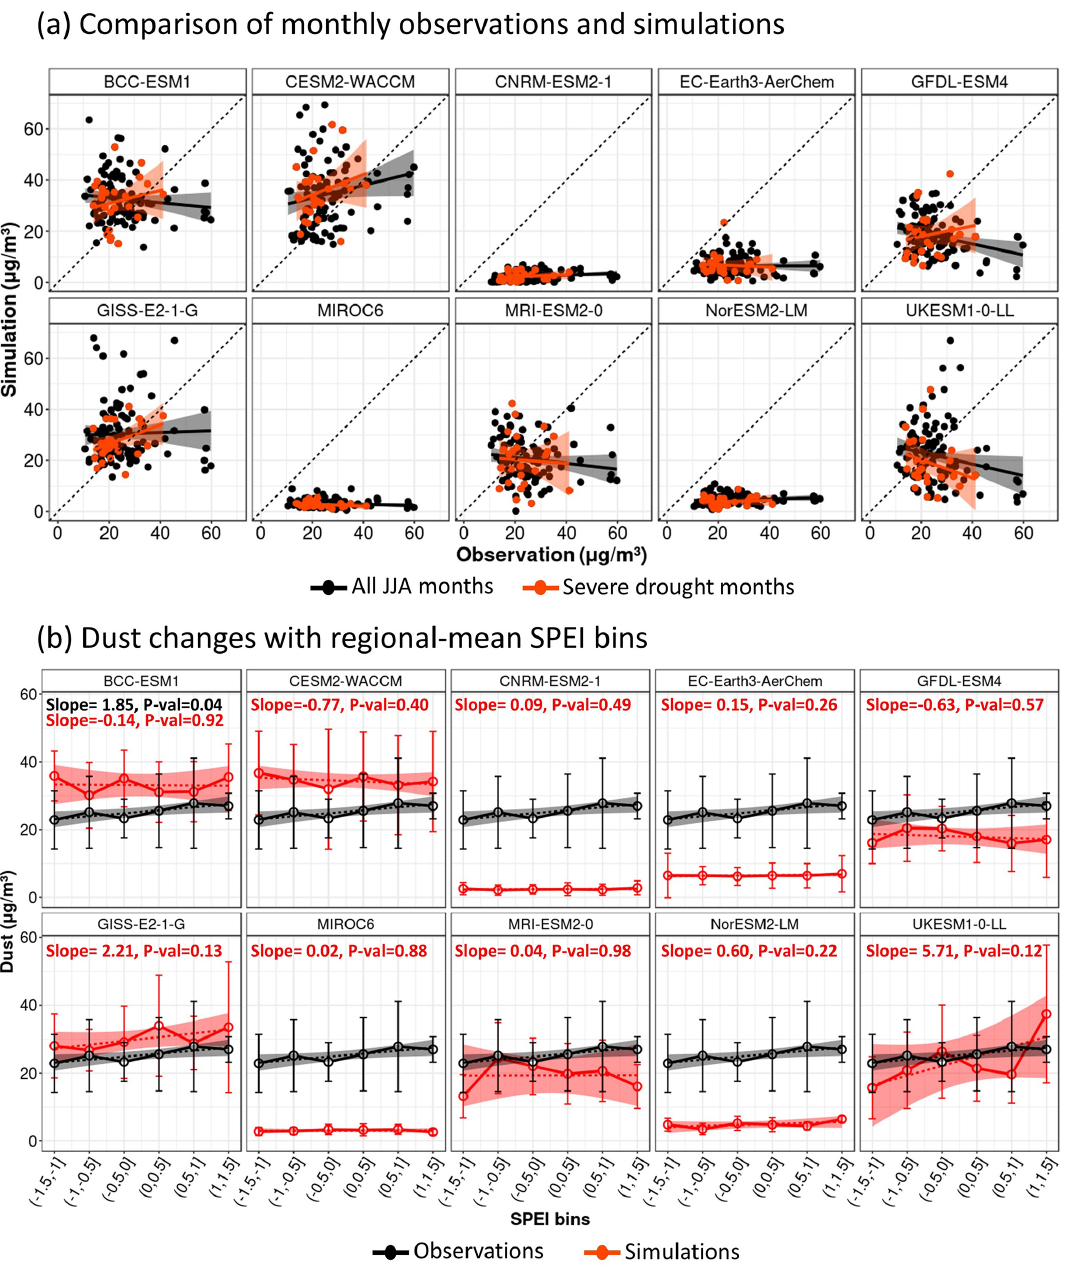
Figure 9. (a) Scatterplots between dust observations and 10 CMPI6 models during 1973–2014 in JJA. Black dots and lines represent dust in all the JJA months and their linear regression fits, respectively. Red dots and lines indicate the same analysis but using the SPEI-based severe-drought months only. The shading indicates a 95% confidence level of the linear regressions. The dashed lines correspond to the 1 : 1 correlation. (b) Observed and simulated dust means (dots) and standard deviations (error bars) varying with the SEUS regional-mean SPEI. Dashed lines represent the linear regressions of the average dust concentrations with their slopes (Slope) and P values ( P -val) listed at the top of each